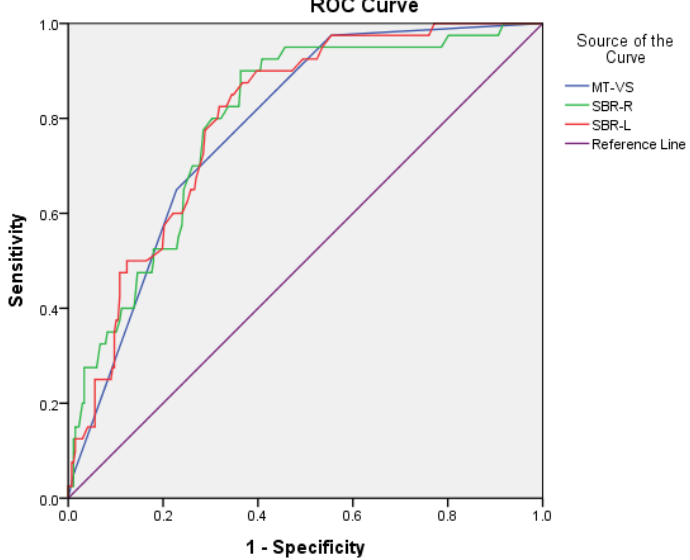
Figure 2. Comparison of area under the curve (AUC), sensitivity, and specificity for MT-VS, SBR-R, and SBR-L between PDD/DLB and AD groups. Detailed comparison of sensitivity, specificity, AUC, and cutoff scores for the diag- nosis of Lewy body disease (LBD) among the machine learning-visual scale (MT-VS) and striatal-background ratio (SBR) for Tc99m TRODAT-1 is demonstrated in Table 3. Table 3. Comparison of sensitivity, specificity, area under curve (AUC), and cutoff scores for the diagnosis of Lewy body disease (LBD) among the machine learning-visual scale (MT-VS) and stria- tal-background ratio (SBR) for Tc99m TRODAT-1. MT-VS